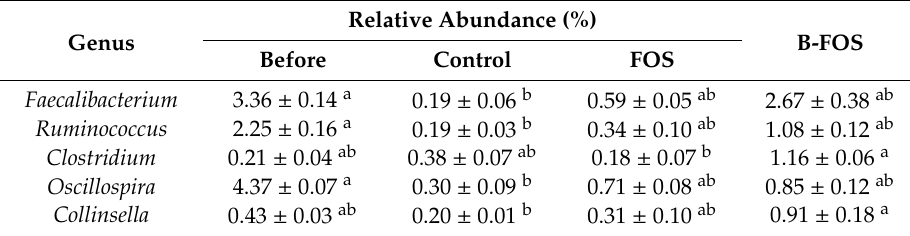
Treatments with di ff erent letters are significantly di ff erent at p <